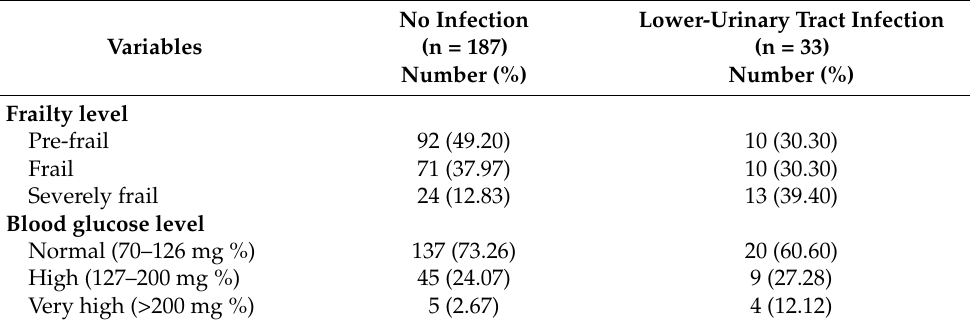
Table 2. Urinary tract infections in older adults undergoing major noncardiac surgery stratified by frailty and blood glucose